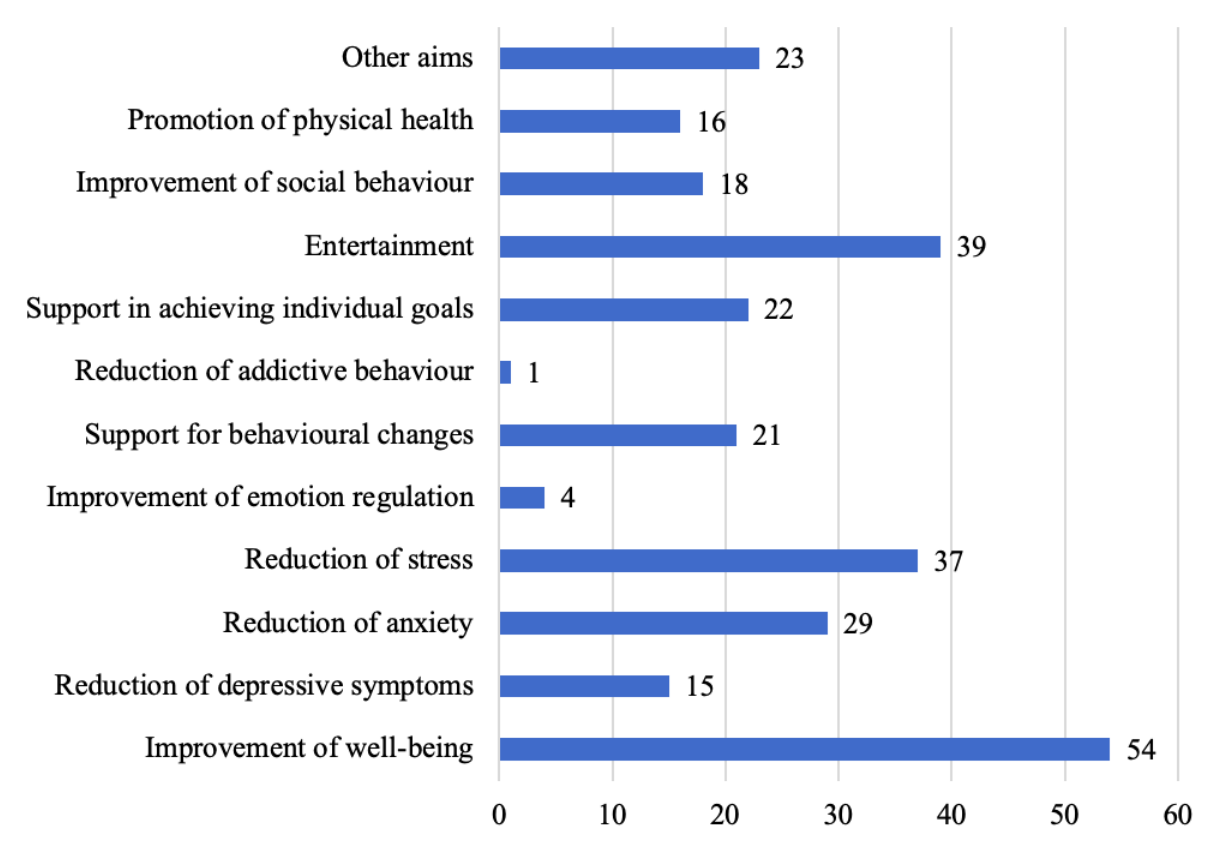
Figure 2. Frequency of objectives of mobile apps for older adults. Multiple naming of objectives for one mobile app was possible. Data are given for n=83 mobile